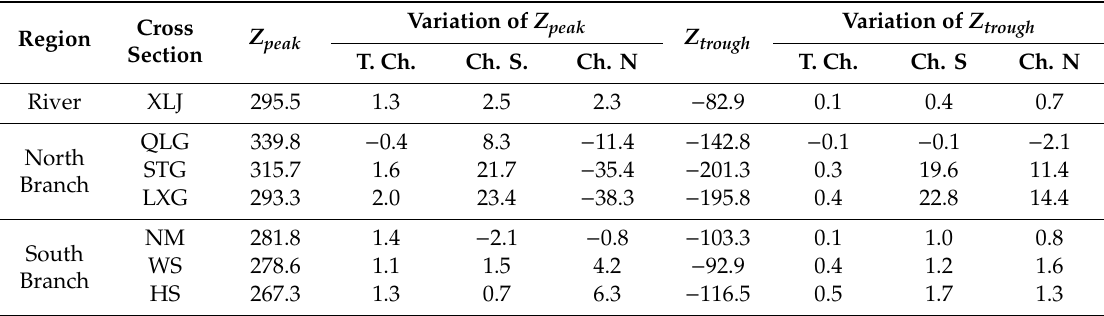
Table 5. Variations of cross-sectional water levels ( Z ) in Yangtze Estuary after GYS Regulation (cm).